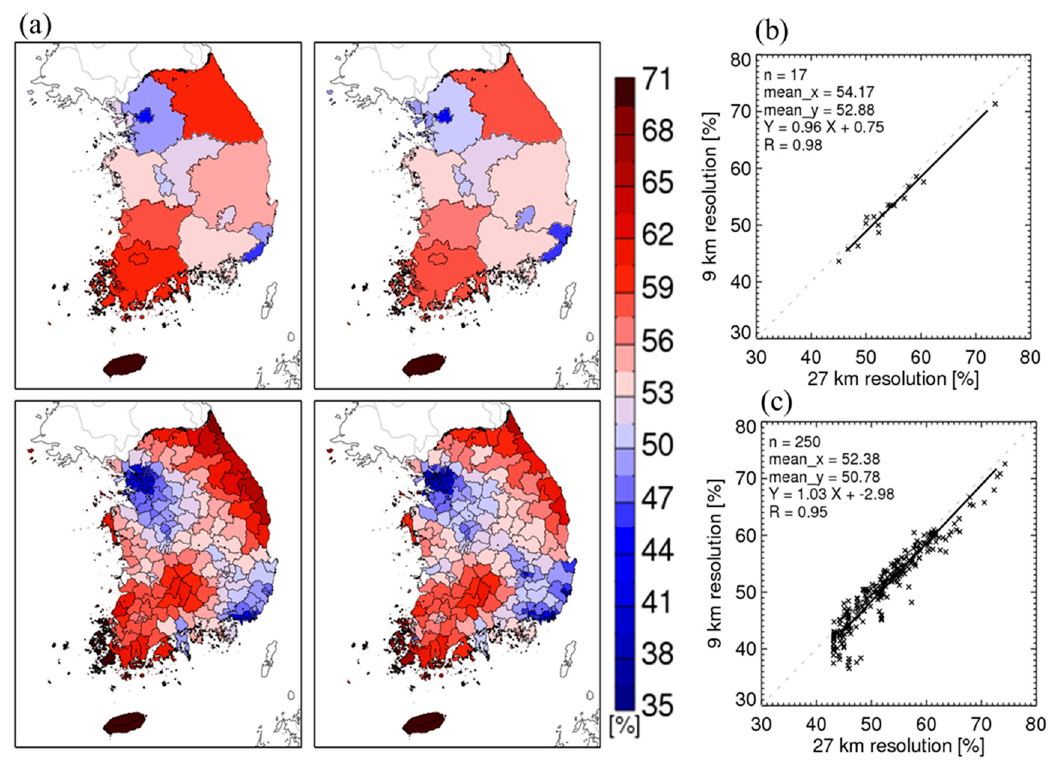
Figure 5. The eight-year mean Chinese contribution to PM 2.5 concentrations in 17 provinces ( a-top ) and 250 prefectures ( a-bottom ) in South Korea estimated via the 27- ( a-left ) and 9-km ( a-right ) simulations from 2010 to 2017. Scatter plots of the Chinese contribution estimated via the 27- and 9-km simulations for ( b ) the 17 provinces and ( c ) the 250 prefectures.